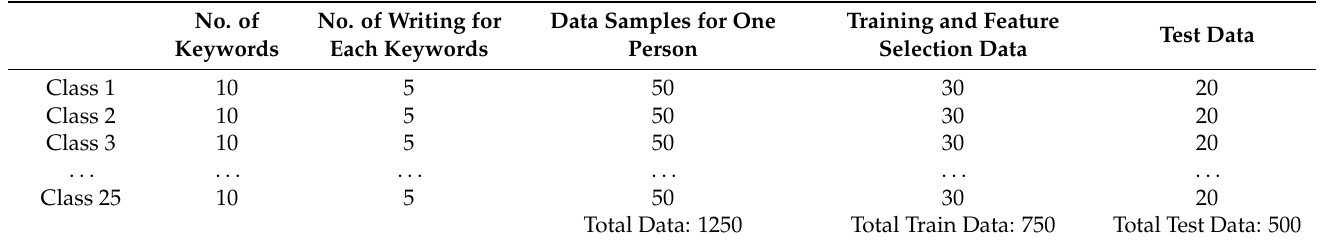
Table 4. Summary of Training and Testing Data